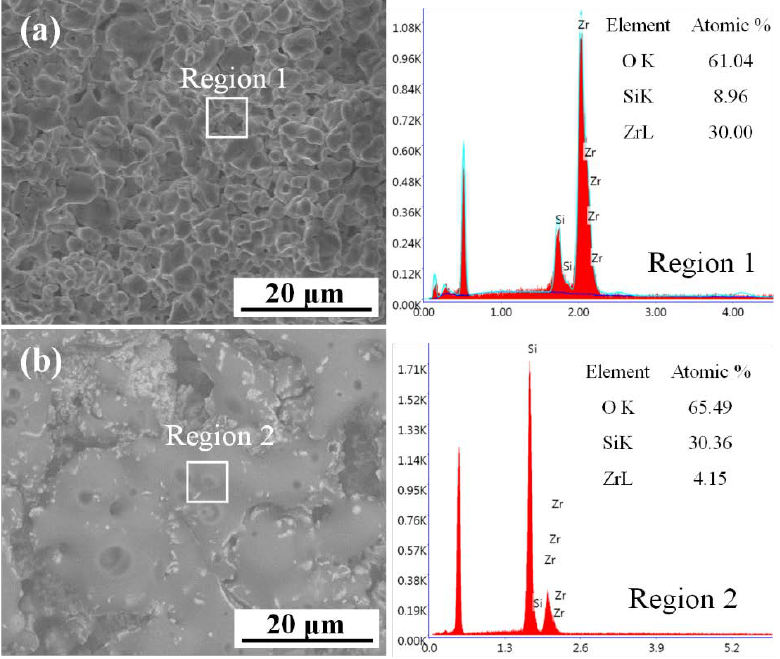
Figure 12. Surface morphologies of the S3-A and S3-B coatings after ablation for 60 s. ( a ): S3-A; ( b ): S3-B.